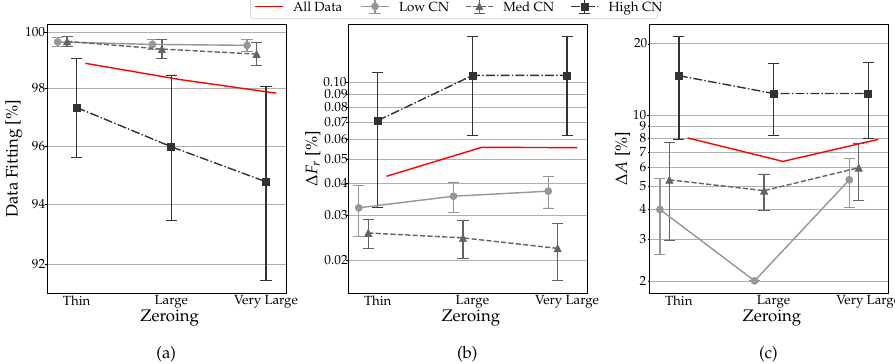
Figure 16. Zeroing trends in functions of zeroing areas and CN values: ( a ) data fitting, ( b ) ∆ F, ( c ) ∆